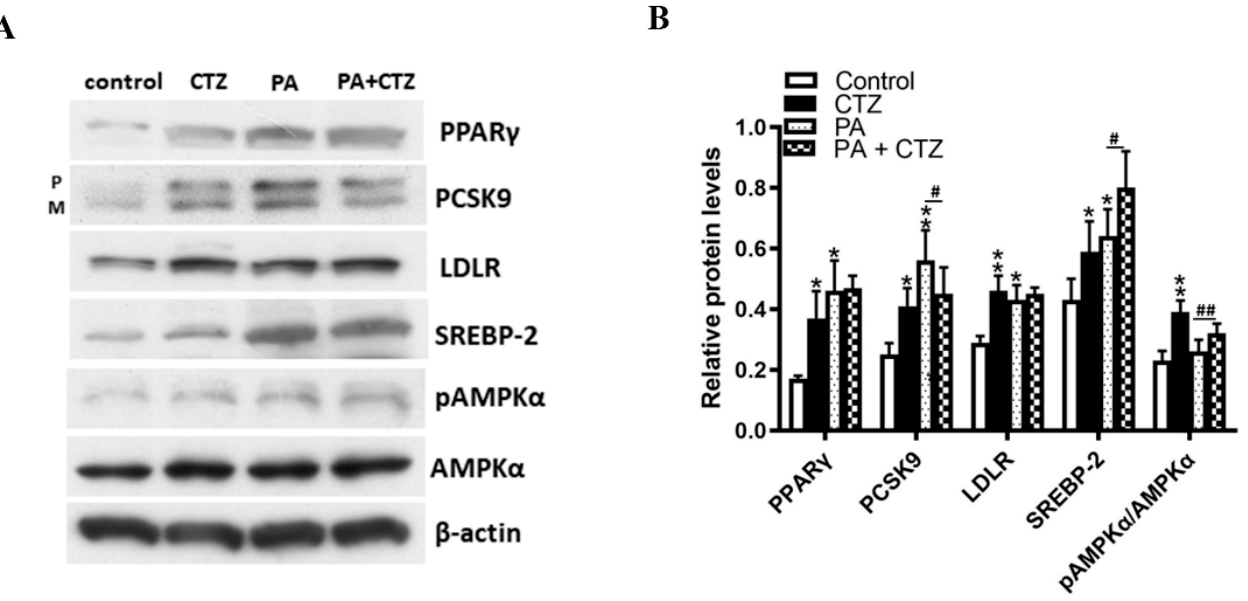
Figure 4. Diverse effects of cilostazol on PCSK9 levels in HepG2 cells treated with palmitic acid (PA) or without. ( A ) HepG2 cells were pretreated with or without 250 μ M PA incubated in the culture media for 24 h. Protein levels of PPAR γ , PCSK9, LDLR, SREBP-2, and phosphorylated AMPK α in HepG2 were measured by Western blotting. β -actin was used as a loading control. ( B ) Quantification of blot intensity relative to loading control is shown. * p < 0.05 and ** p < 0.01 versus vehicle control. # p < 0.05 and ## p < 0.01 versus HepG2 cells treated with PA and vehicle.